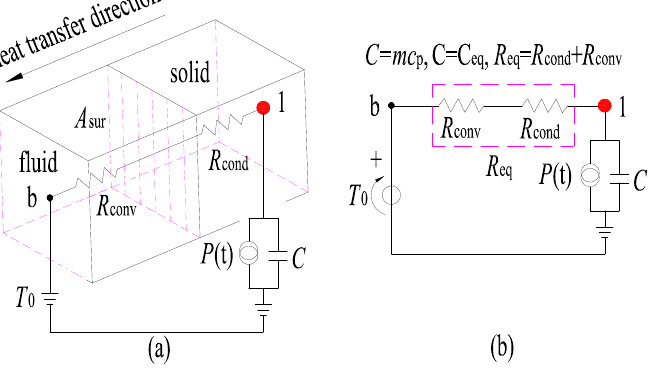
Figure 3. First-order model without air clearance and its thermal network. ( a ) First-order model, ( b ) first-order thermal network.